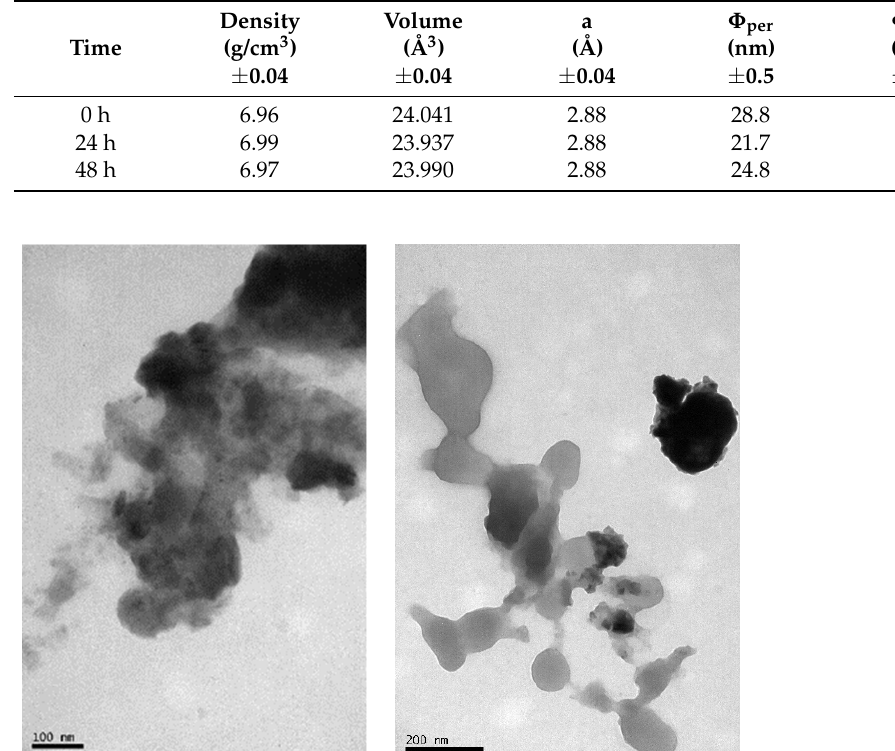
Table 1. XRD parameters of the Fe 90 Al 10 system with thermal treatment at 1000 ◦ C for 7 days and mechanically alloyed with oleic acid as a surfactant for 24 and 48 h of milling time, respectively (the (a) column corresponds to the lattice parameters; the columns with ( Φ per ) correspond to the mean crystallite size perpendicular to the radiation, the column with ( Φ par ) corresponds to the mean crystallite size parallel to the radiation). Figure 1. XRD of the Fe 90 Al 10 system with thermal treatment (TT) at 1000 °C for 7 days and mechan- ically alloyed with oleic acid as a surfactant for 24 and 48 h, respectively.